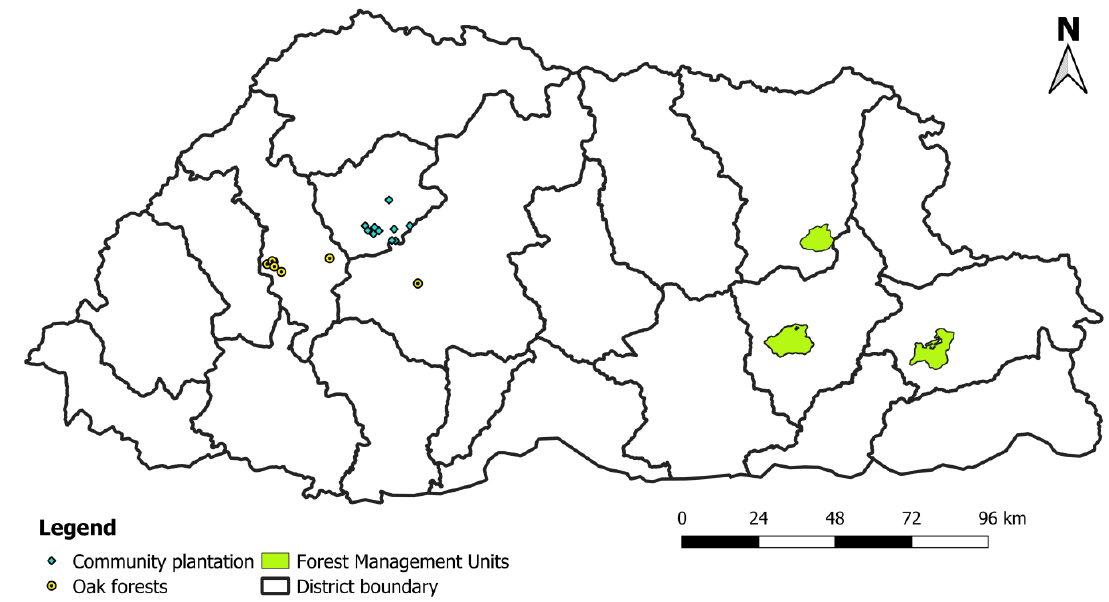
Figure 2. Map of Bhutan and district boundaries with the three study areas indicated.